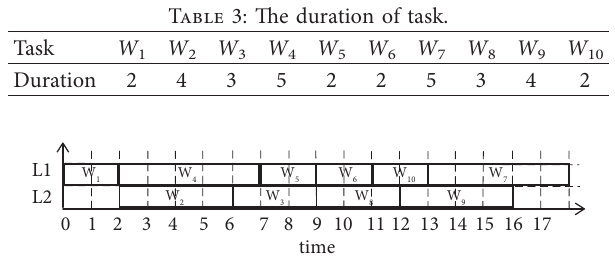
Figure 3: The Gantt diagram of the resource-task assignment. Table 4: The task-resource assignment of schedule.